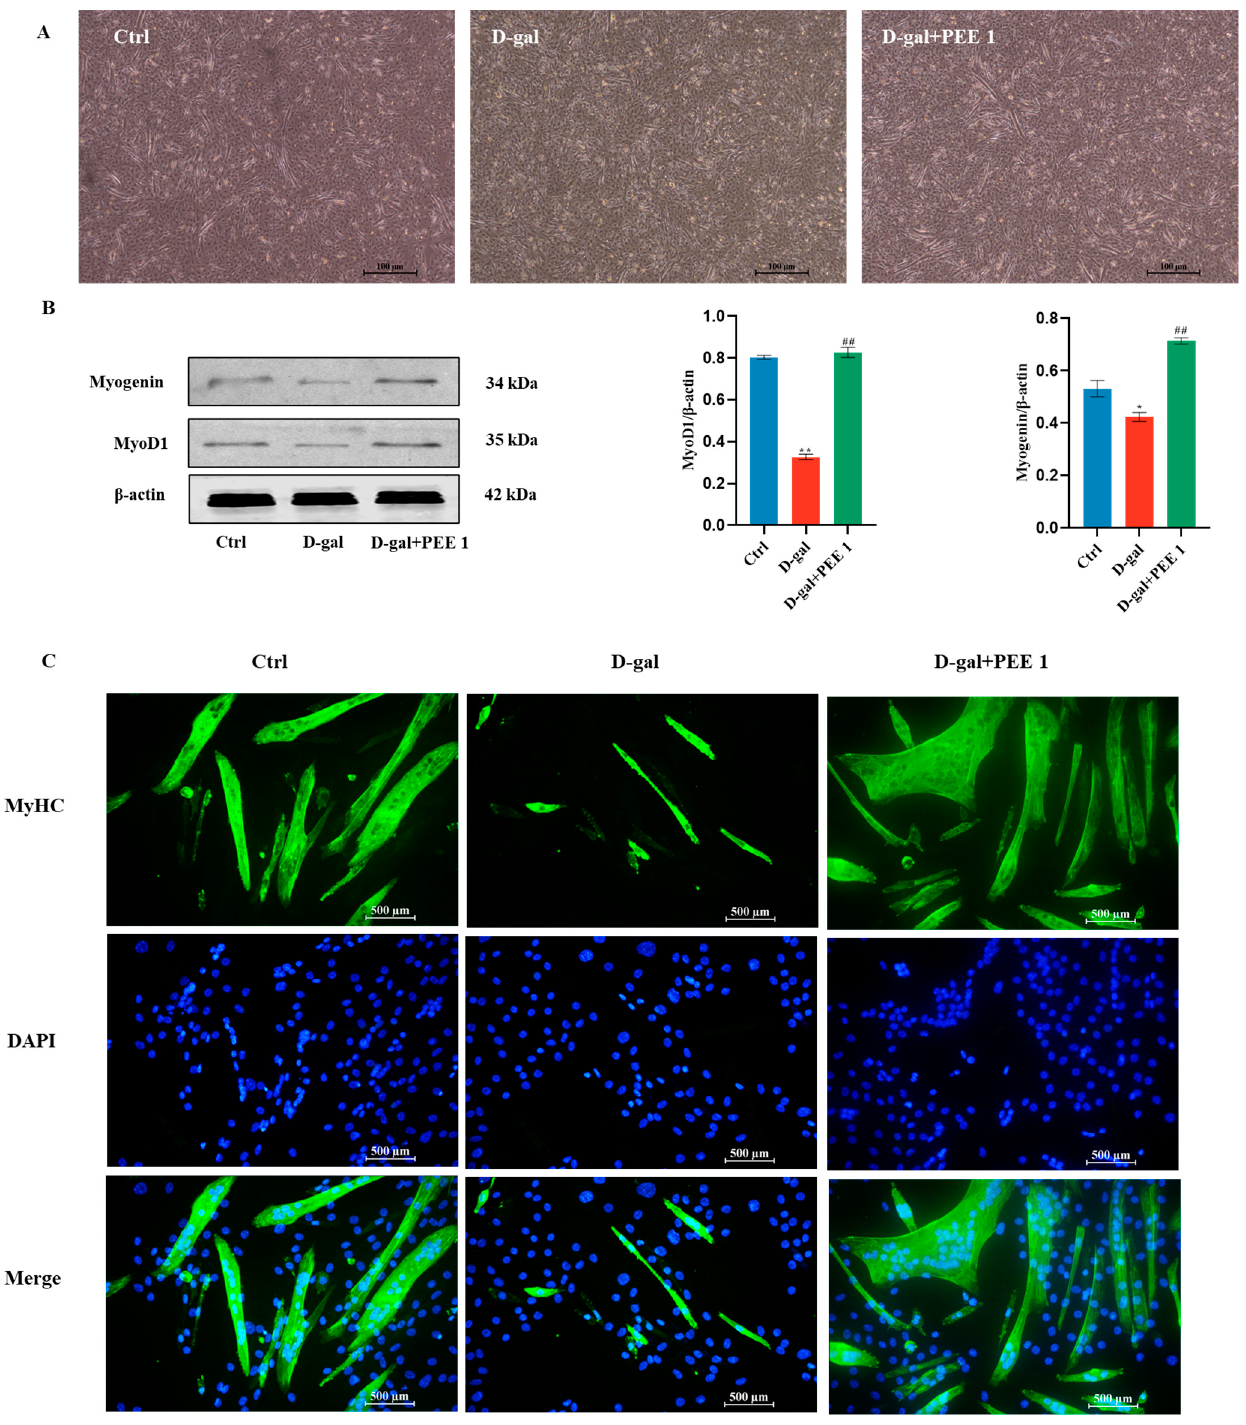
Figure 2. PEE alleviated the impairment of di ff erentiation capacity of D-gal-treated C2C12 cells. ( A ) Morphological changes in the number and size of myotubes after PEE treatment of C2C12 cells (scale bar = 100 µm). ( B ) Western blot and quanti fi cation for MyoD, and Myogenin. ( C ) The fl uo- rescence staining for myosin heavy chain (MHC), indicator of Myotubular fusion (scale bar = 500 µm). All data are expressed as mean ± SEM (n = 3). * p < 0.05 and ** p < 0.01 vs. Ctrl; ## p < 0.01 vs. D-gal.